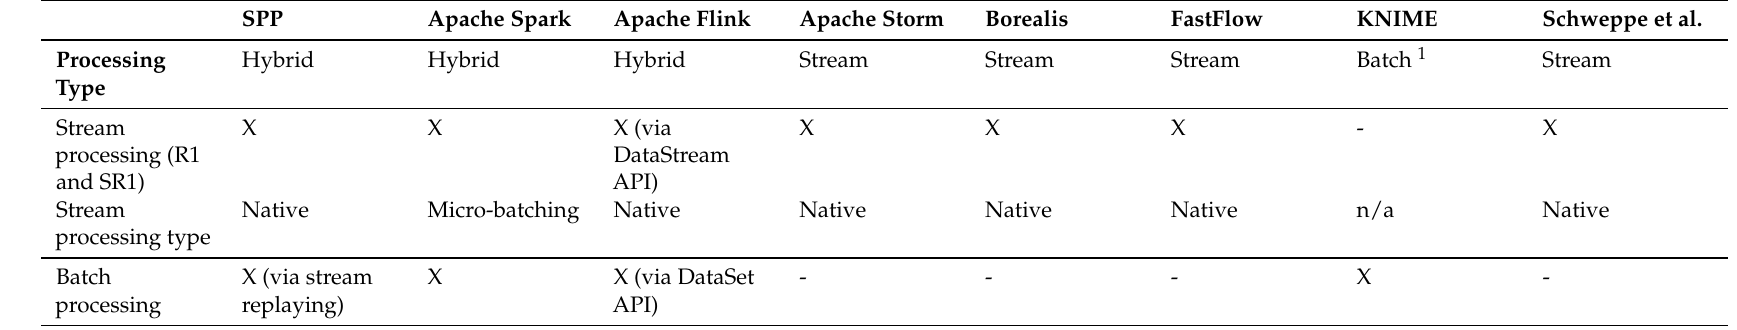
Table A2. Functional